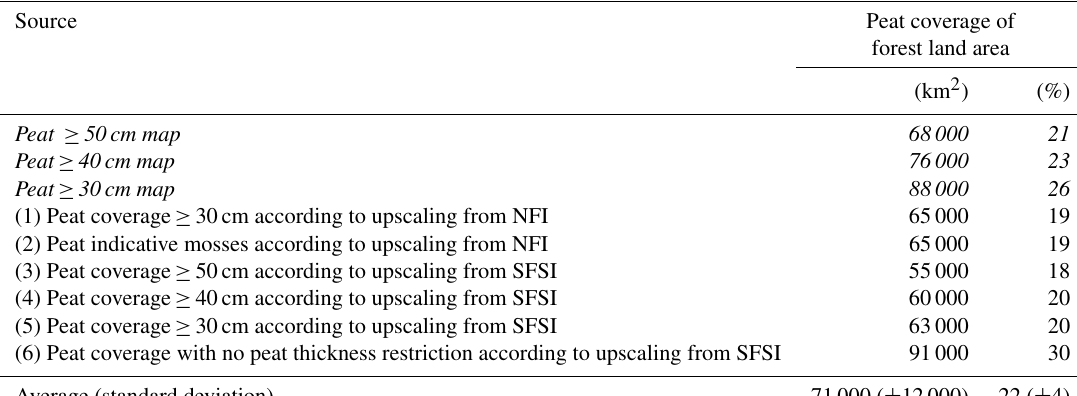
Table 3. Peatland coverage in km 2 or in percent of forest land according to different sources. The peat maps that we predicted in this study are marked in italics. The numbering refers to the different upscaling estimates from inventory data as described in Sect. 2.6. Forest land includes productive forest land, pastures, mires, rock outcrops, and alpine region below treeline, but excludes arable land, alpine region above treeline, railroads, power lines, roads, and urban areas. However, the exact definitions differ slightly among sources which can explain some inconsistences in the % cover among the three data sources in the table (maps, NFI, and SFSI data), see Sect.